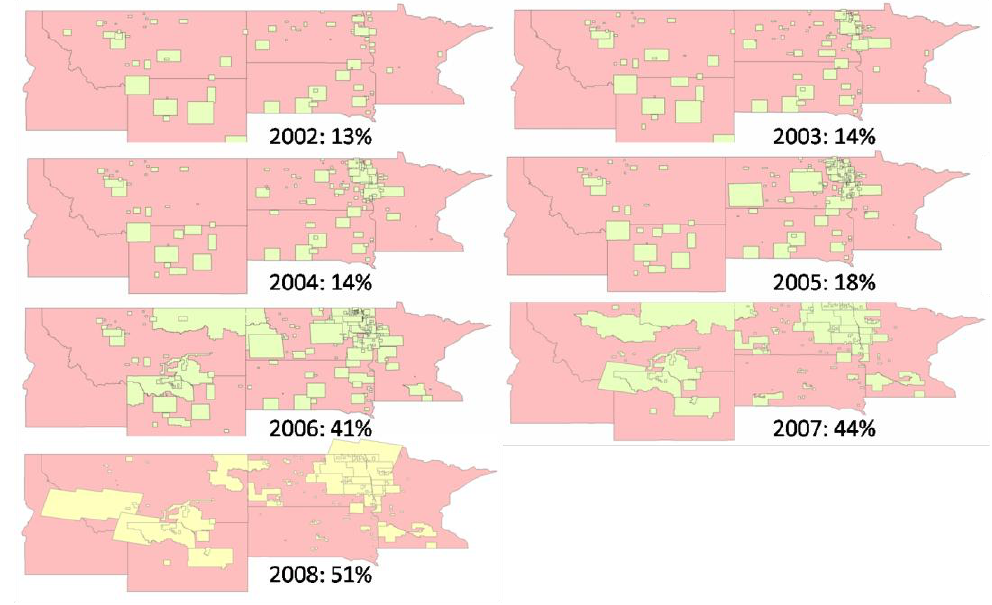
Figure 3. Areas of interest for which users have requested remote sensing images between 2002 to 2008 are overlaid on a map of six states of North and South Dakota, Minnesota, Montana, Wyoming, and Idaho. Numbers after each year indicate the percentage of AOI relative to the total geographic